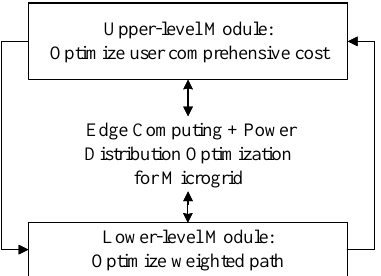
Figure 2. Schematic diagram of bilevel optimization